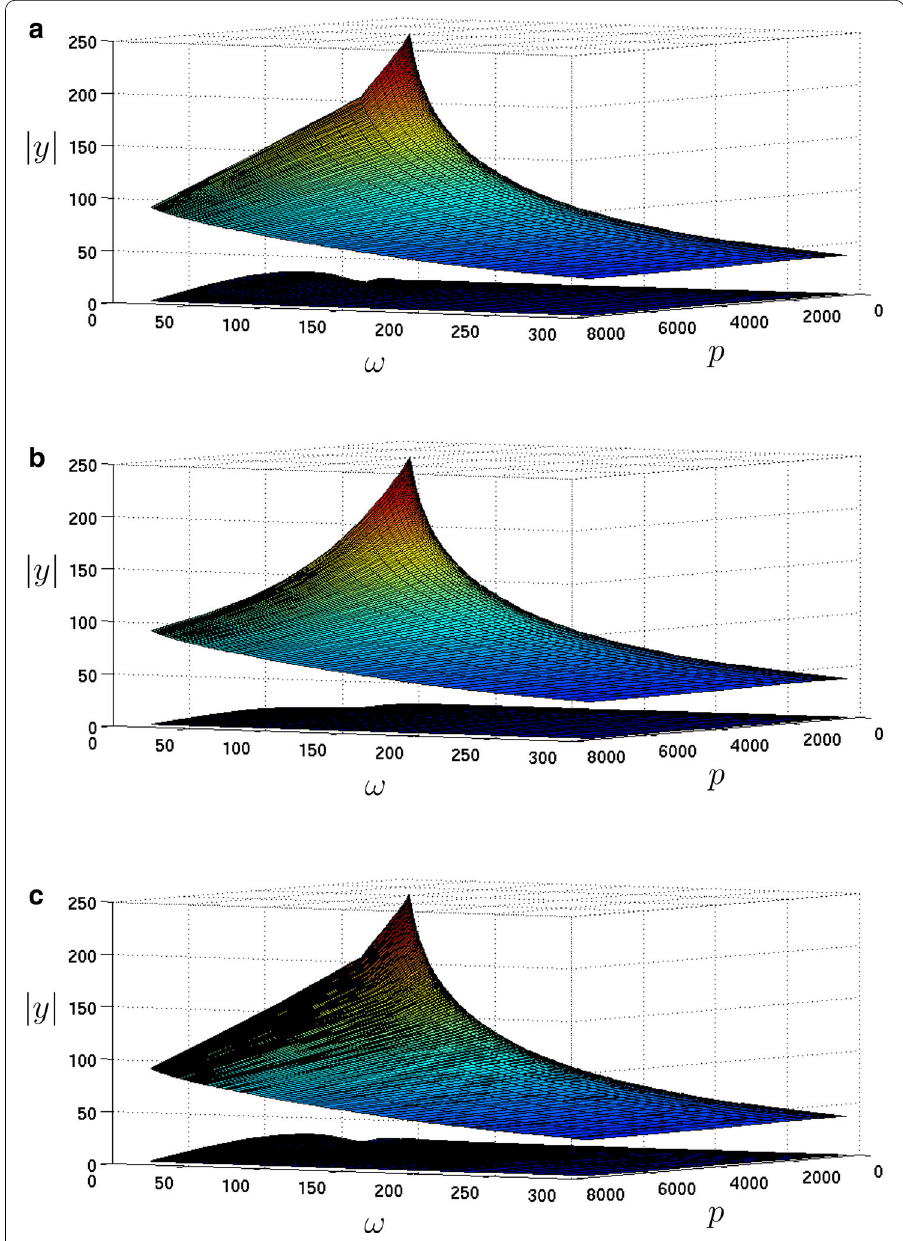
Fig. 7 Response surface and the absolute error. a Linear interpolation of the Loewner representation. The overall relative error is 2 . 4649 × 10 − 2 . b Spline interpolation of the Loewner representation. The overall relative error is 6 . 0671 × 10 − 3 . c Linear interpolation of the pole-residue representation. The overall relative error is 2 . 3485 × 10 −